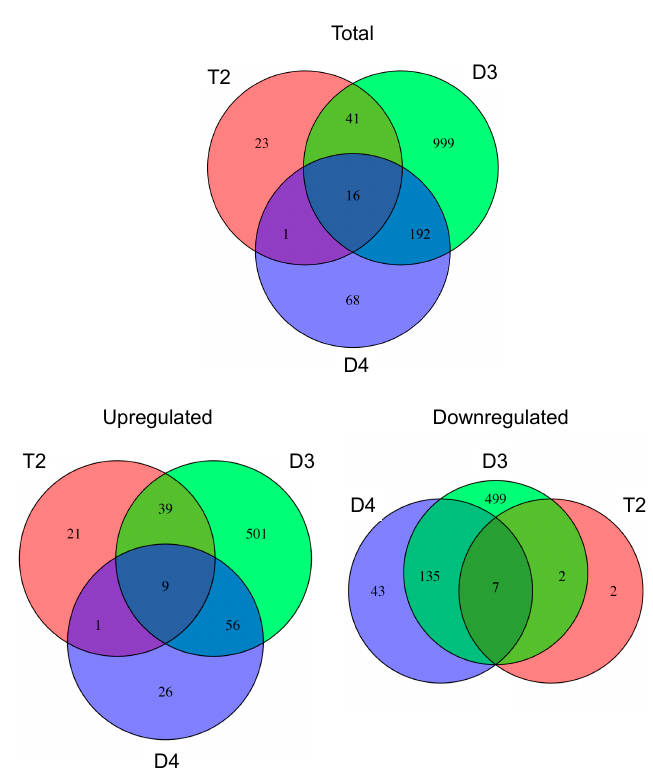
Figure 2. Venn diagram showing overlap between D3, T2, and D4 for all genes differentially expressed in response to inoculation in each species, as well as for sets of upregulated and downregulated genes considered separately.